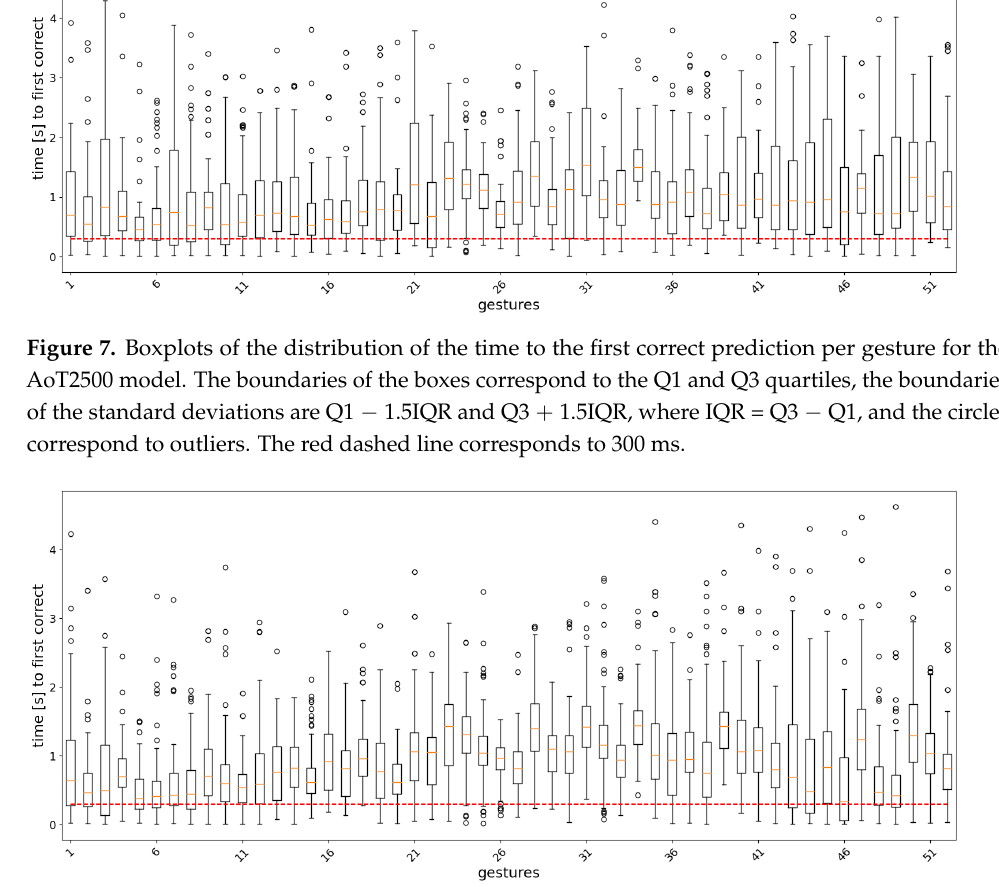
Figure 8. Boxplots of the distribution of the time to the first correct prediction per gesture for the Att300 model. The boundaries of the boxes correspond to the Q1 and Q3 quartiles, the boundaries of the standard deviations are Q1 − 1.5IQR and Q3 + 1.5IQR, where IQR = Q3 − Q1, and the circles correspond to outliers. The red dashed line corresponds to 300 ms.